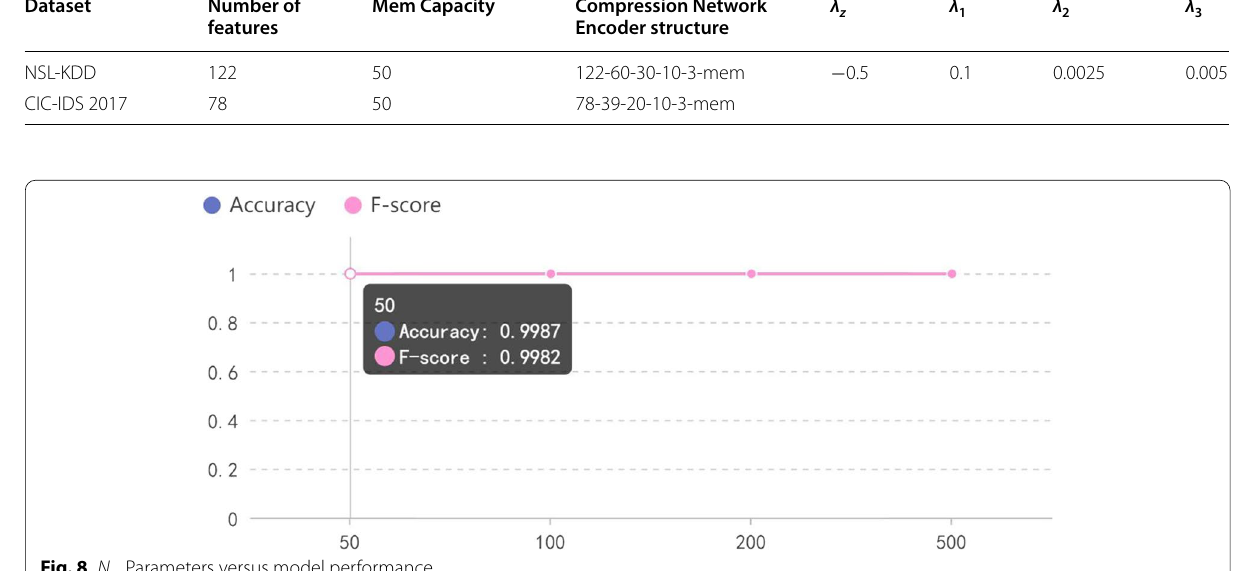
Fig. 8 N m Parameters versus model